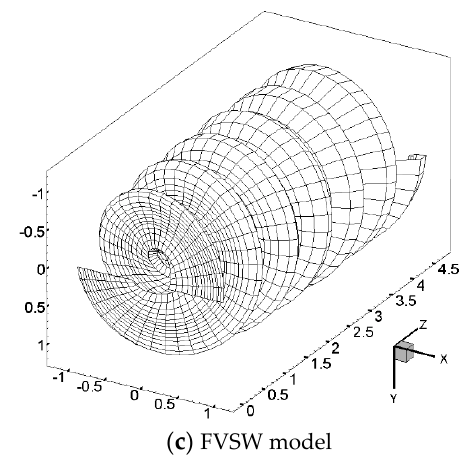
Figure 14. Wake geometries (front view) at four times the radius distance behind the rotor at 10 m/s calculated using the ( a ) VSRW model, ( b ) TVW model, and ( c ) FVSW model.